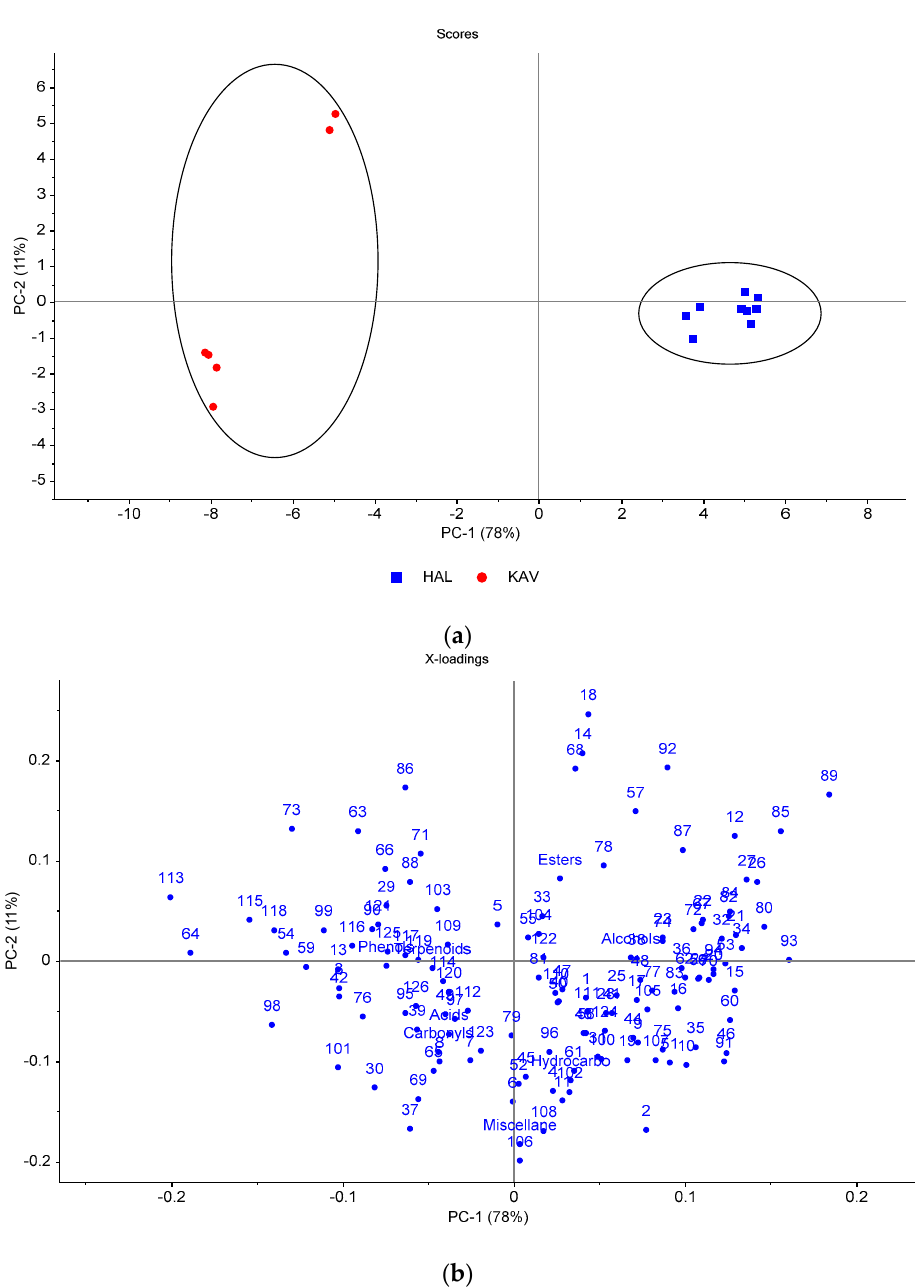
Figure 4. Principal component analysis of the volatile compounds identified in cv. Halkidiki green olives grown in Halkidiki (HAL) and Kavala (KAV): ( a ) scores plot, ( b ) loadings plot of the first two principal components. The codes of variables are given in Table 2.